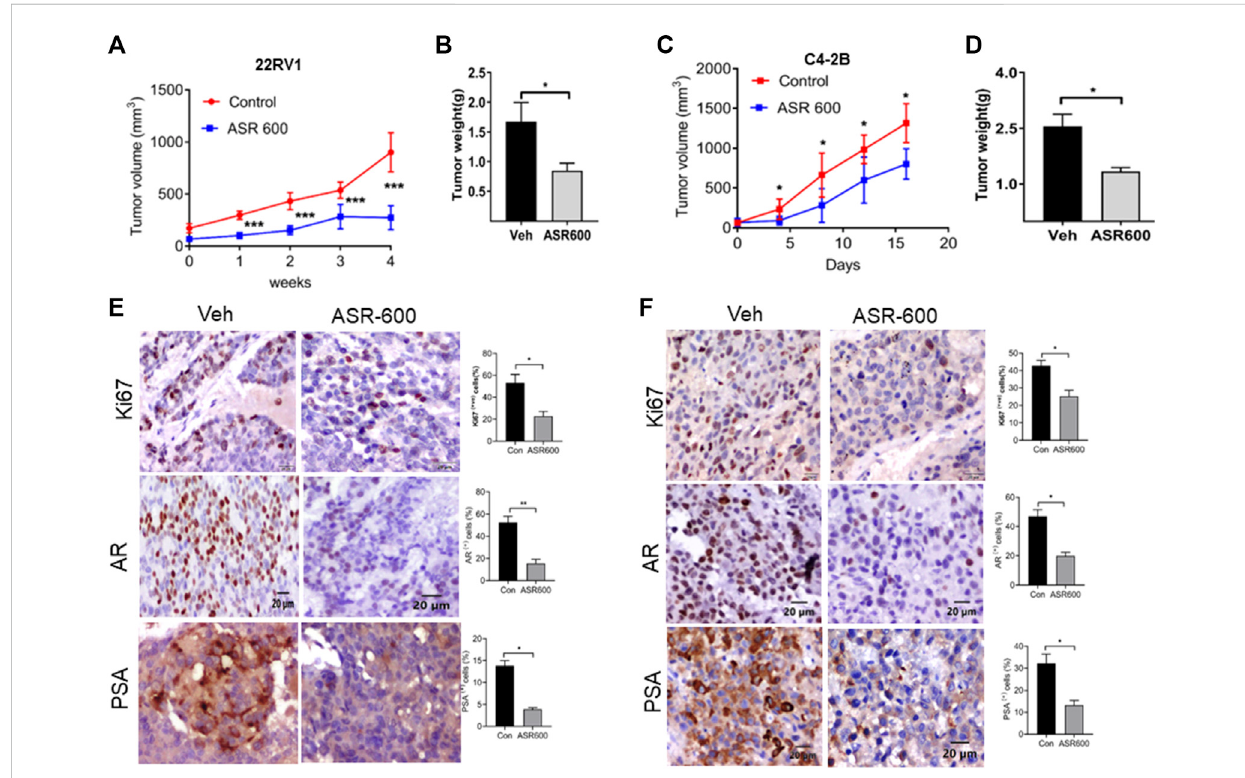
FIGURE 9 The therapeutic effect of ASR-600 on Xenotransplanted prostate tumors. (A, C) Oral administration of ASR-600 (20 mg/kg) inhibited the xenotransplanted tumors from 22Rv1 & C4-2B tumors. Tumor volumes were measured once per week for 4 weeks, and a line graph was plotted to compare tumor growth volume (mm 3 ). (B, D) Tumor weight for vehicle and ASR 600-treated 22Rv1 and C4-2B tumors. (E, F) Immunohistochemistry analyses of tumor samples were performed to evaluate the expression of Ki67, AR and PSA in 22Rv1 and C4-2B xenografted